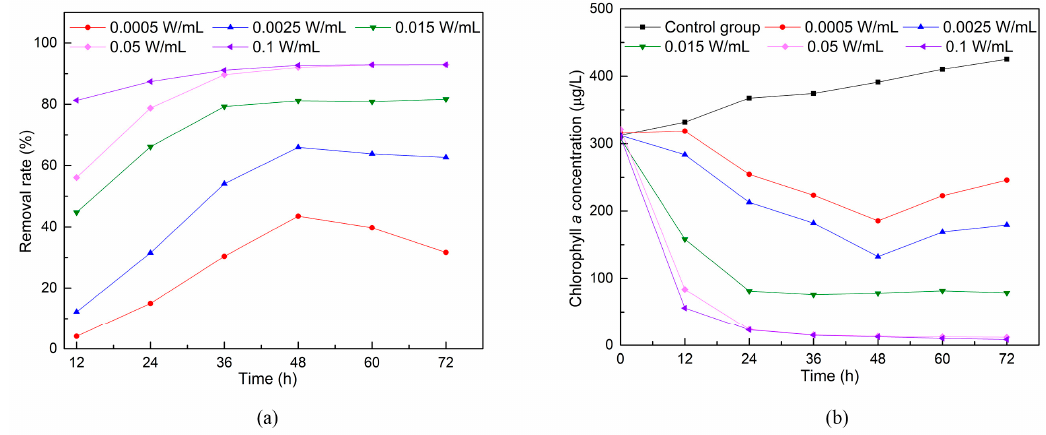
Figure 6. ( a ) Algae removal rates and ( b ) concentrations of chlorophyll a after treatment at different ultrasonic densities.